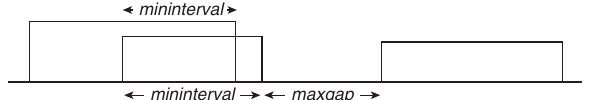
Figure 1. Construction of Intervals for Finding a